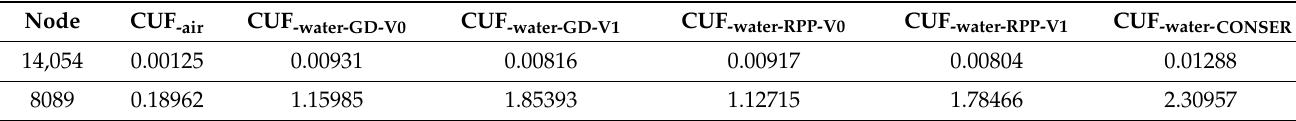
Table 7. The cumulate fatigue usage factor in air and water environments using different strain rate approaches and F en expressions of RPV inlet nozzle. Node CUF